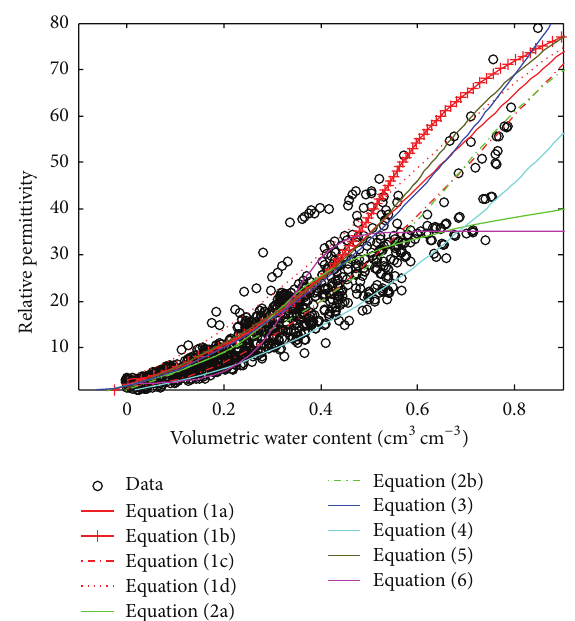
Figure 2: Comparisons using all data for (1a) to